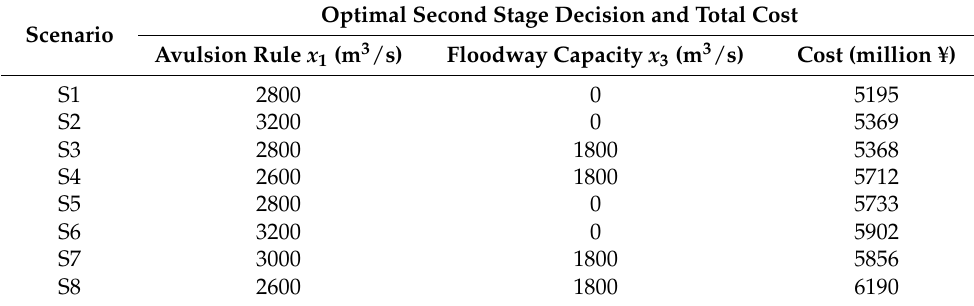
Table 5. Summary of optimal second stage decision for each scenario, given first stage decision